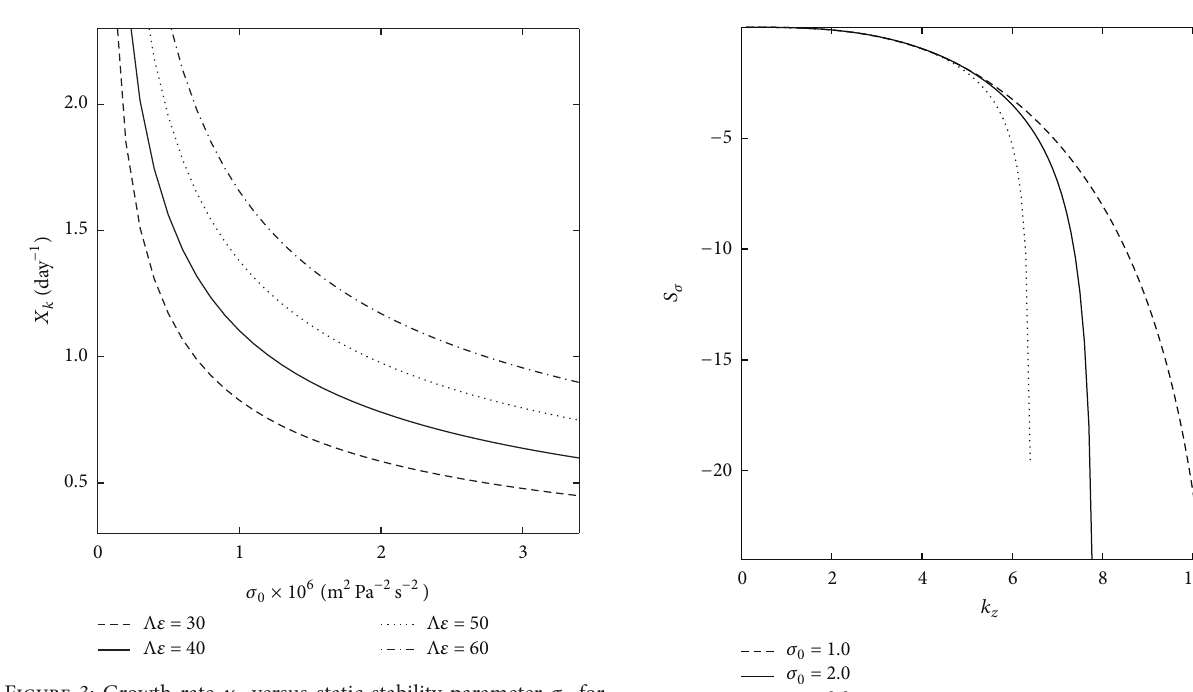
Figure 3: Growth rate 𝜒 𝑘 versus static stability parameter 𝜎 0 for different values of parameter Λ 𝜉 (units ms −1 ).